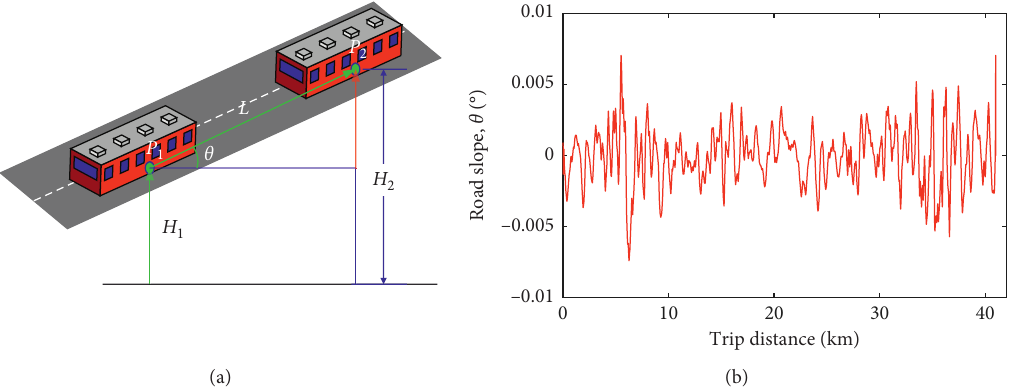
Figure 7: The formation of the road slope for a bus route. (a) Sketch map of the road slope and (b) road slope of the bus